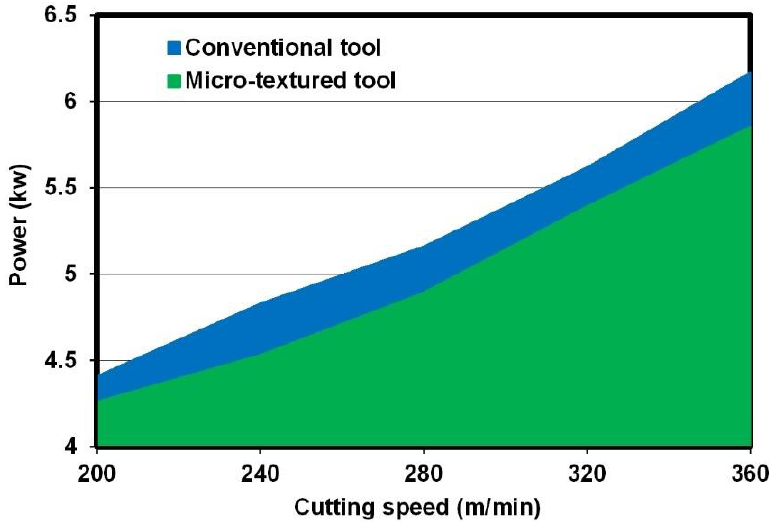
Figure 6. Comparison of power consumption of the used milling machine between operations with different cutting